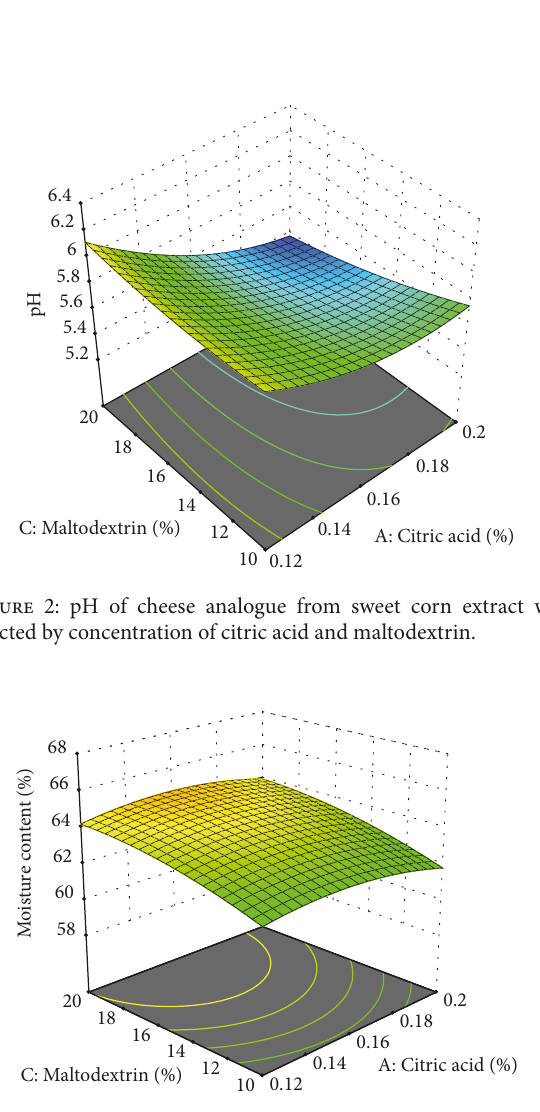
Figure 3: Moisture content of cheese analogue was affected by concentration of citric acid and